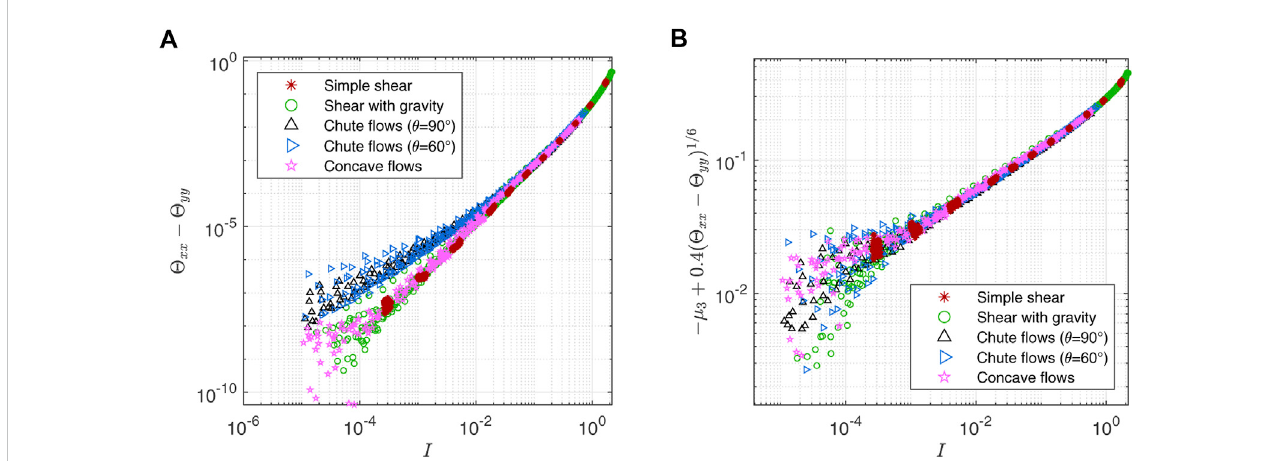
FIGURE 7 (A) Differencebetweentwodiagonalelementsofdimensionlessgranulartemperaturetensor( Θ xx − Θ yy ).Chute fl owdatadivergefromtheotherdataas I decreases, which is similar to the μ 3 behavior in Figure 6A. (B) Adding 0 . 4 ( Θ xx − Θ yy ) 1/6 to − μ 3 may be an alternative way to calibrate μ 3 because it seems to collapse data into a line.